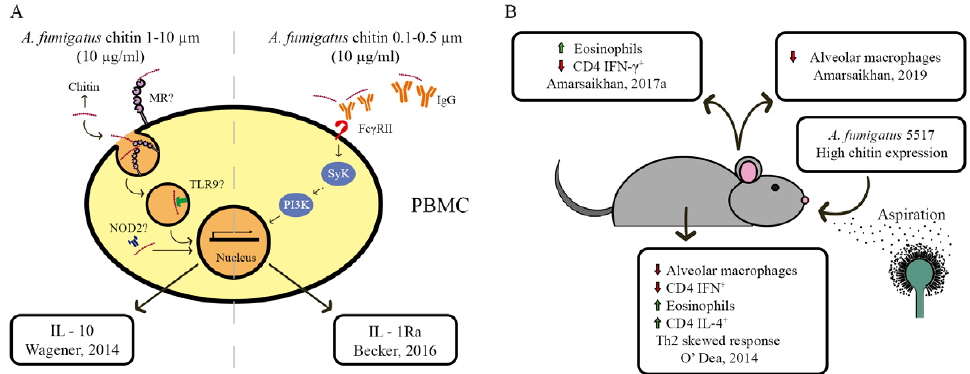
Figure 5. Chitin is important for the recognition of fungal pathogens by the mammalian immune system. ( A ) A. fumigatus purified chitin and its interaction with human PBMCs. Human PBMCs showed an increase in IL-10 secretion upon stimulation with A. fumigatus chitin, although this was not statistically significant. Furthermore, the receptor that mediates the increase in IL-10 upon stimulation with purified chitin, remains to be determined. Instead, when A. fumigatus chitin was opsonized with IgG, production of the anti-inflammatory cytokine IL-1Ra was observed. Subsequently, the A. fumigatus chitin-IgG complex activates the PBMC Fc- γ receptors, resulting in the activation of the Syk and phosphatidylinositol 3-kinase (PI3K) kinases and cytokine secretion. PBMC: periph- eral blood mononuclear cells; IL-: Interleukin; MR: mannose receptor; TLR: toll-like receptor 9; NOD2: nucleotide-binding oligomerization domain containing 2. ( B ) Mice that aspired conidia of an A. fumigatus high chitin-containing strain (Af5517) displayed an increased Th2-mediated re- sponse in BALF. Indeed, inhaled Af5517 conidia led to increased eosinophils and CD4 IL-4+ T cells in BALF, while alveolar macrophages and CD4 IFN+ showed reduced numbers. BALF: bron- choalveolar lavage fluid [205, 206, 210,211,212].